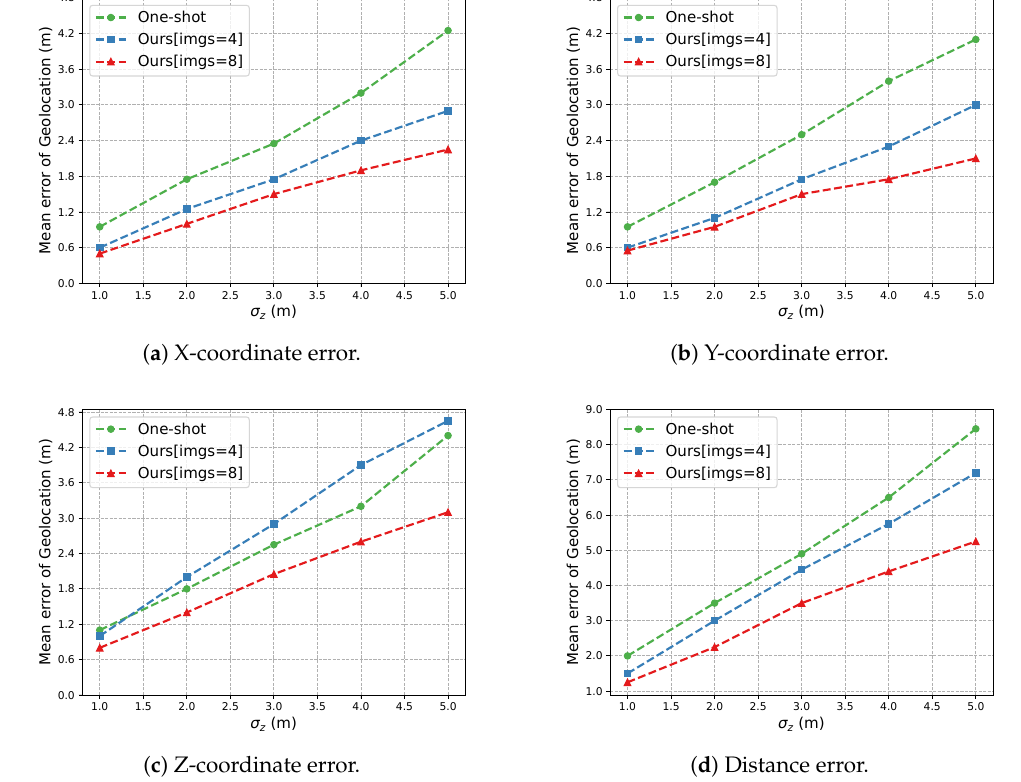
Figure 10. Geolocation errors under different measurement errors of position. In addition to the Gaussian measurement errors, the yaw-angle biases provided by the low-quality sensors also affect the geolocation results. Therefore, we assume that the navigation state has both Gaussian measurement errors and yaw-angle biases, and compare biases. In detail, we set σ ψ = σ θ = σ ϕ = 2 ◦ and σ x = σ y = σ z = 3 m . The yaw-angle